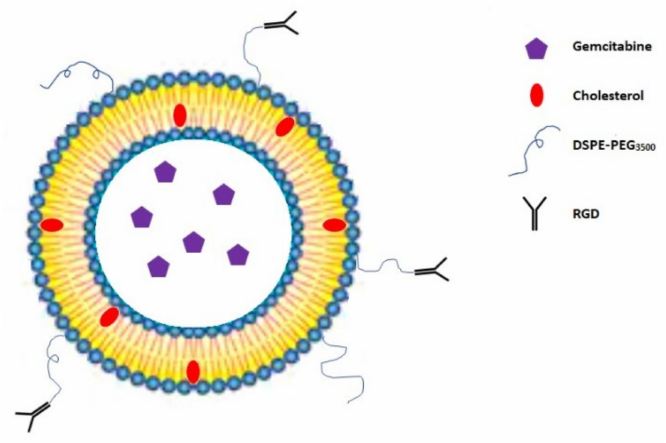
Figure 4. The structure of RGD-coated liposome with encapsulated gemcitabine. DSPE: distearoyl- sn-glycero-3-phosphoethanolamine